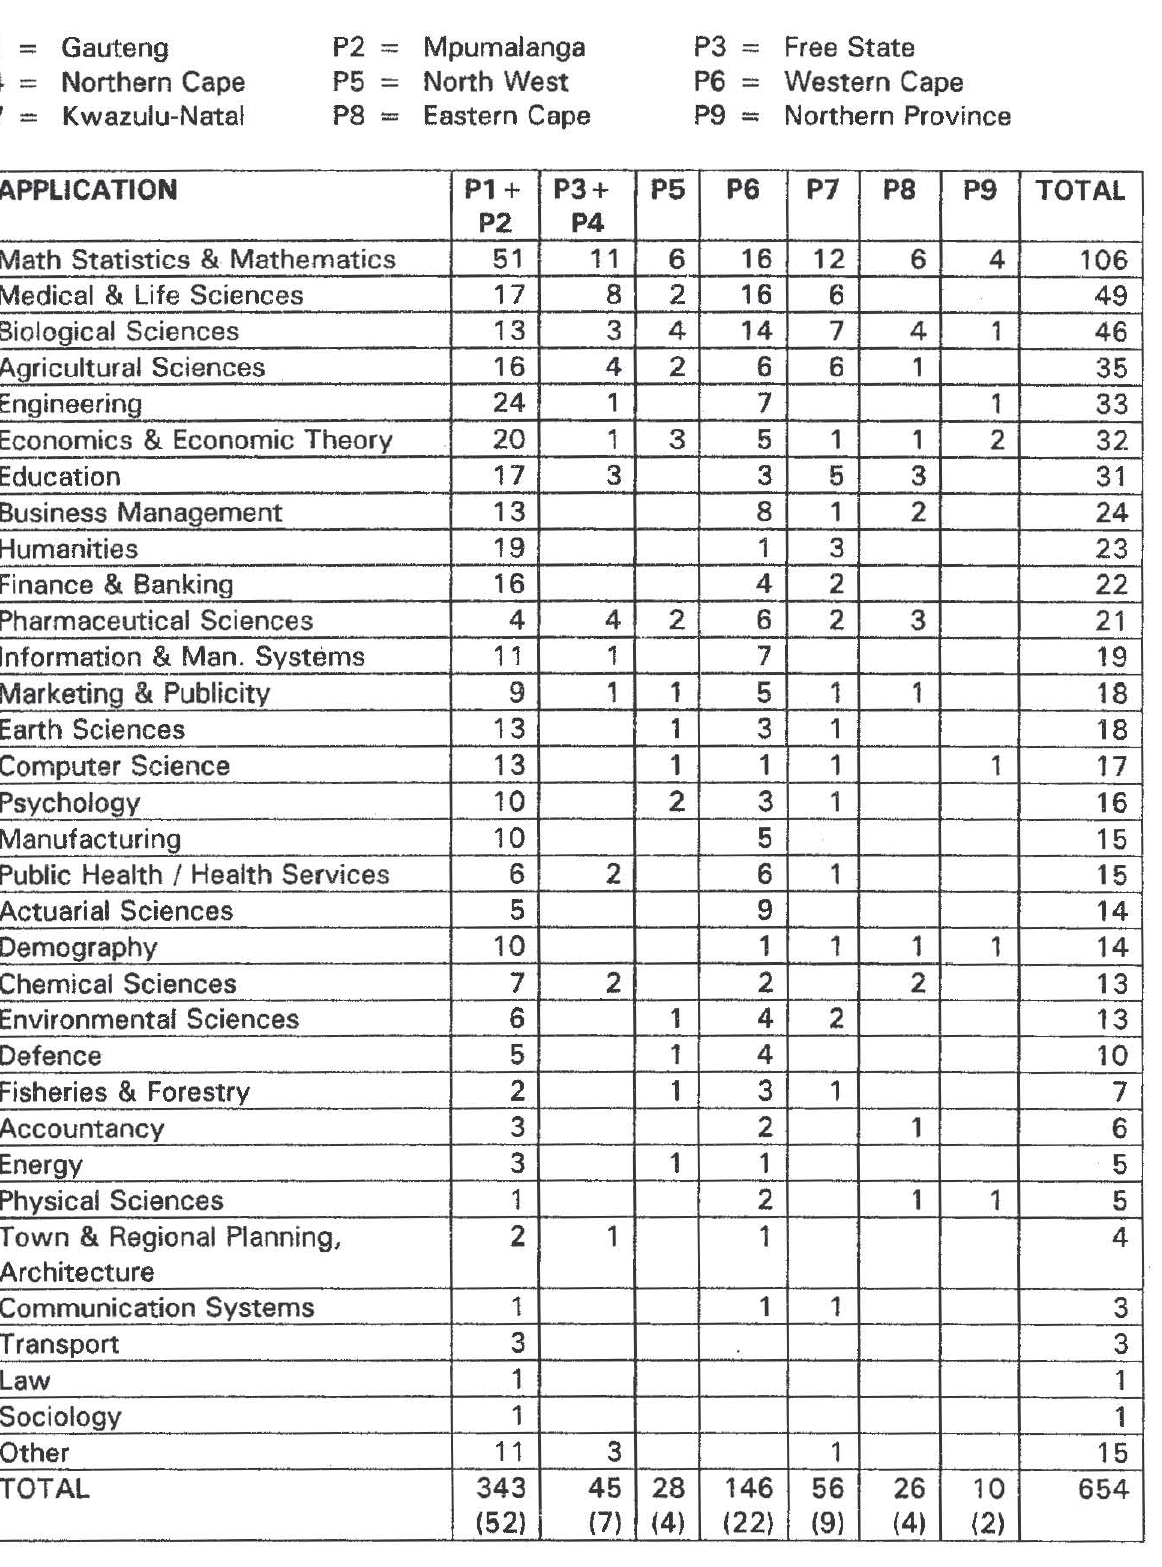
Table 4: Application fields of SASA members over provinces